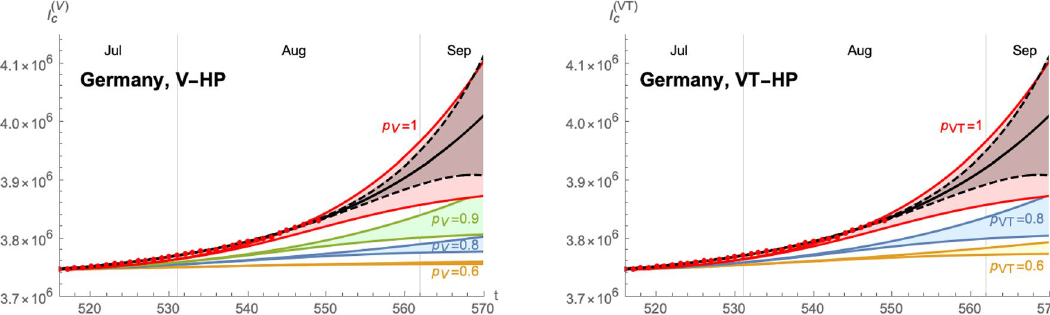
Figure 7. Time evolution of the cumulative number of infected individuals for different values of the efficacy of a V-HP (right panel) or a VT-HP (right panel). We assume that the model has been introduced on 07/07/2021. Both cases use ζ = 0.15 (based on an average of the efficacy of each vaccine weighted by the distribution among the population), ρ = 0.008 and σ 2 /σ 1 = 1